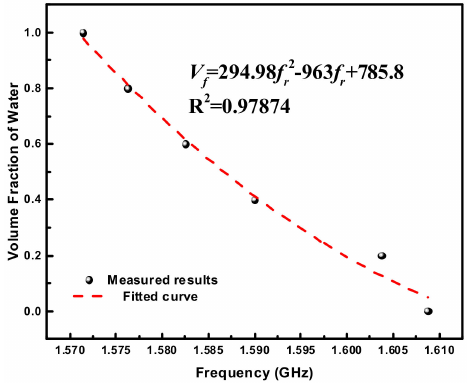
Figure 16. Plots of the volume fraction of water as a function of the resonance